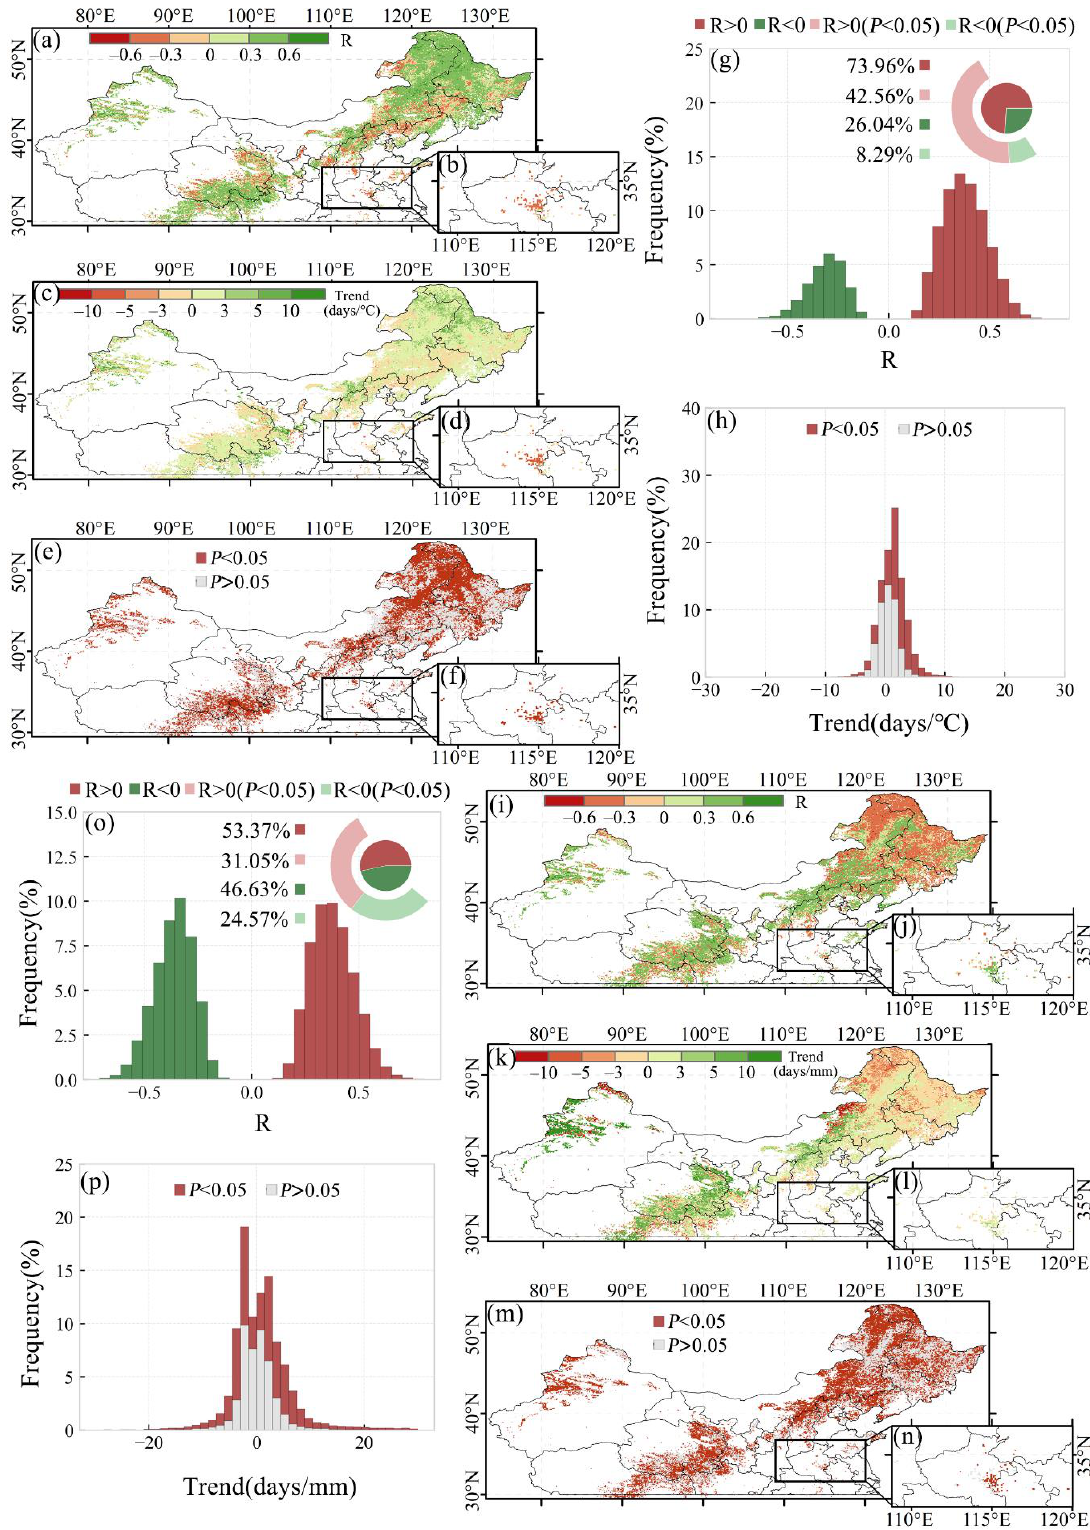
Figure 8. Spatial pattern of the ( a , b ) R-value, ( c , d ) slope, and ( e , f ) statistical significance ( p -value) between EOS and preseason temperature in ( a , c , e ) the first season of the double-season crop, single- season vegetation, and ( b , d , f ) the second season of the double-season crop. ( g ) Frequency distribution histograms of R-value and ( h ) trends. The text in ( g ) indicates the area ratio of the R-value. ( i – p ) The corresponding pictures mentioned before between EOS and preseason precipitation.